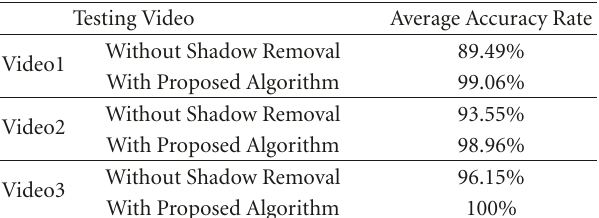
Table 4: Average accuracy of all lanes in each